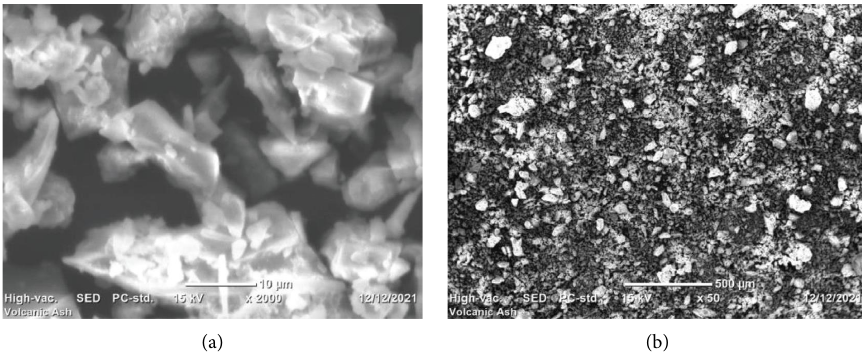
Figure 3: Te SEM image particle distribution of volcanic ash.